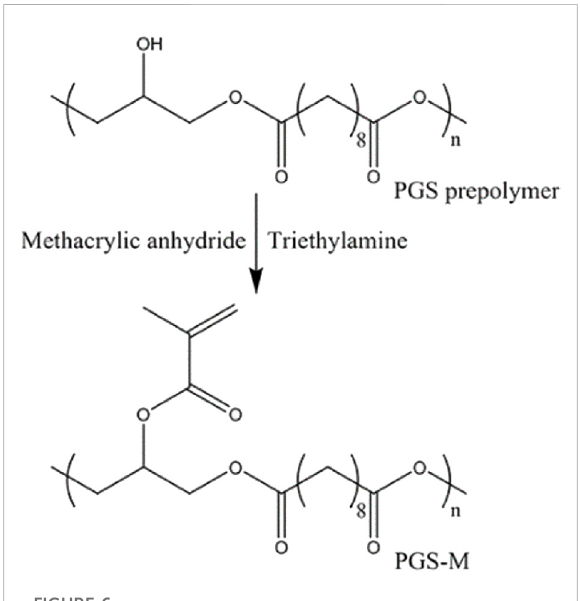
FIGURE 6 Synthesis schemes for PGS prepolymer and